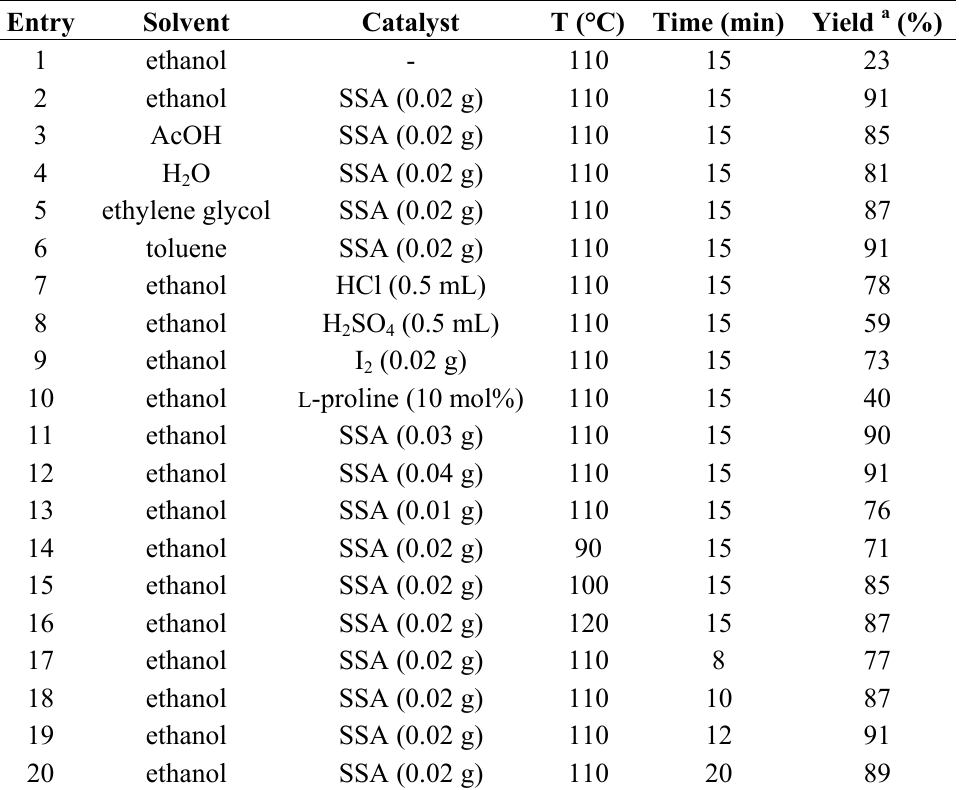
Table 1. Optimization of the reaction conditions for the synthesis of 3a